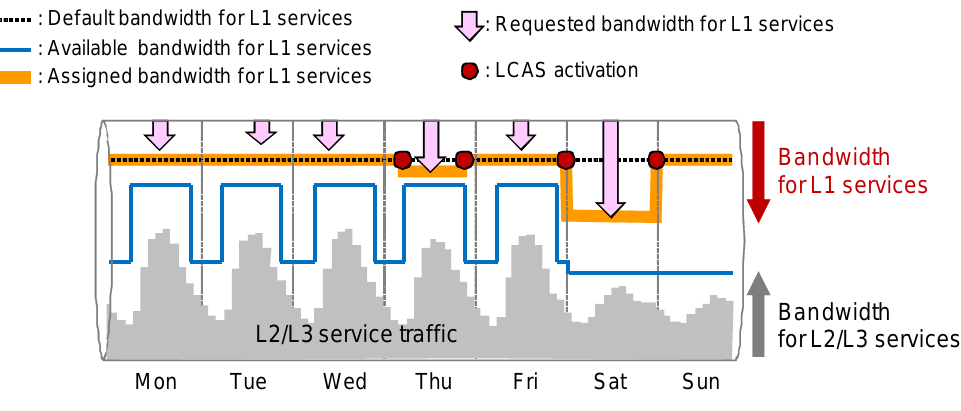
Figure 6. Default/available/assigned bandwidth for layer-1services.